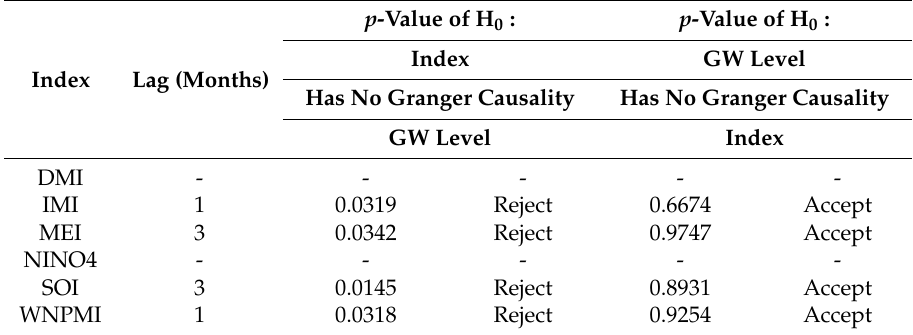
Table 8. Granger Causality Test of the groundwater level leading parameter at the CT30/1 station.